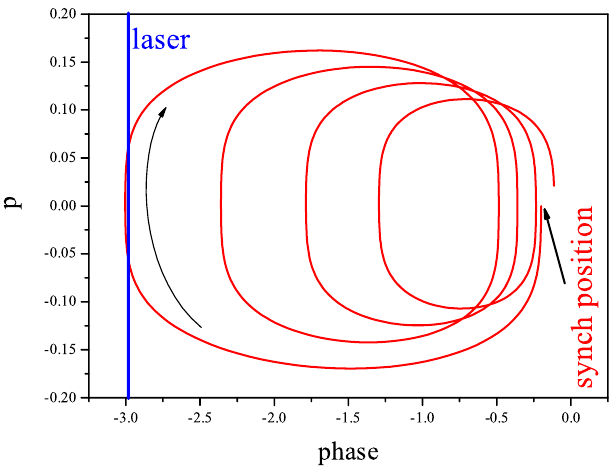
FIG. 5. The bunch center phase vs turn number for different initial phase displacements, without excitation, damping, and RFPM.